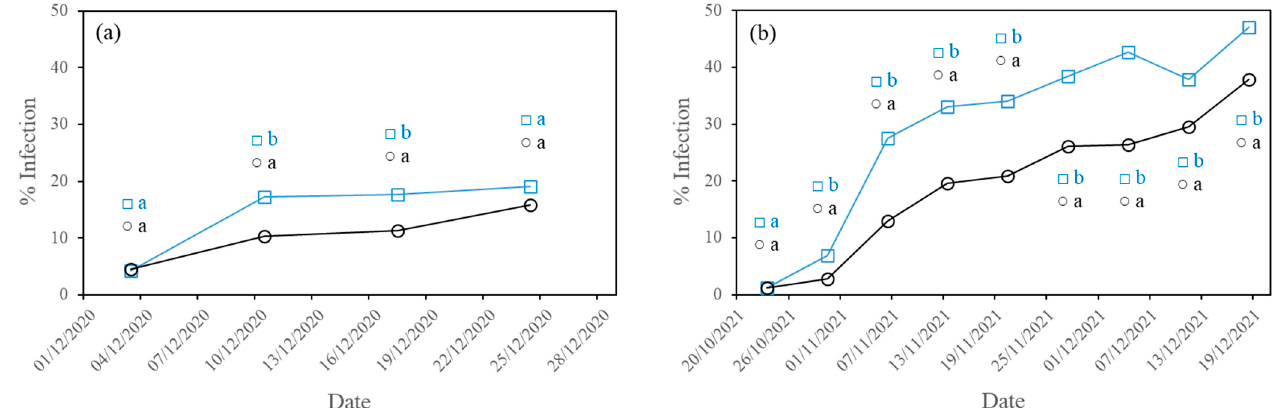
Figure 4. Development of downy mildew ( P. cubensis ) percentage of infection over time, for the first crop cycle ( a ) and for the second crop cycle ( b ). Sector with commercial film C F ( (cid:3) ); Sector with experimental film E F ( ). Different letters indicate statistically significant difference ( p -value ≤ (cid:35)